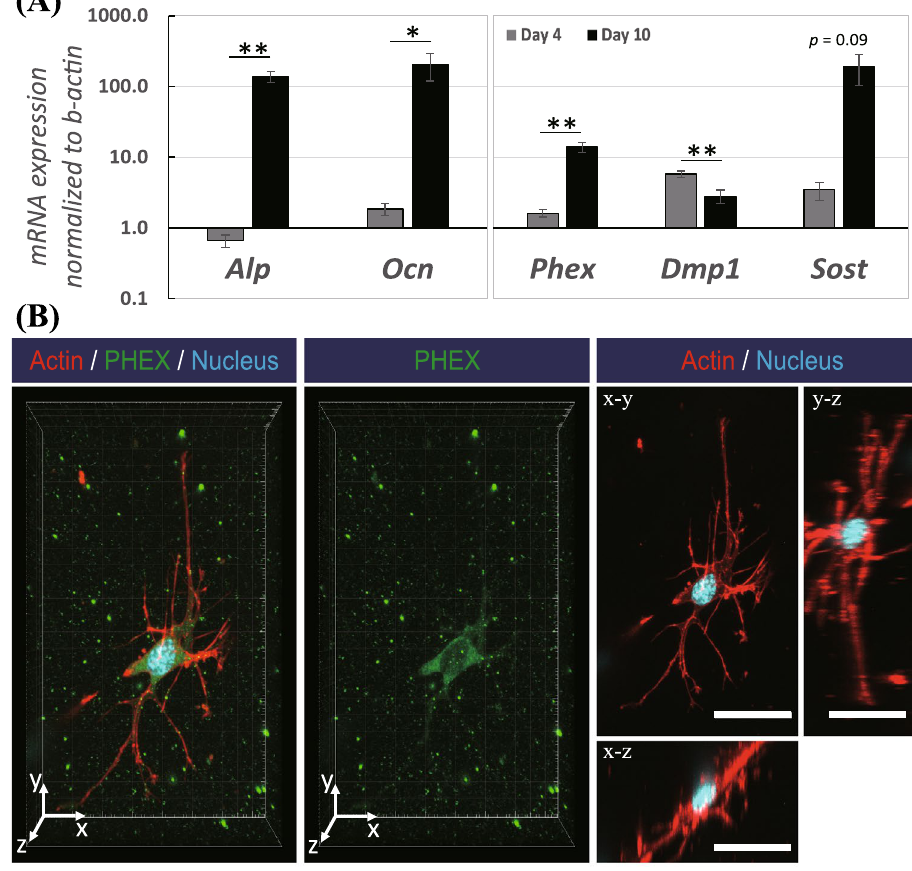
Figure 3. ( A ) The mRNA expressions of genes in osteoblast-like cells in the 2-side fixed matrix after 4 d and 10 d incubation. The mRNA expression of Alp , Ocn , Phex , Dmp1 , and Sost was measured by real-time PCR and normalized to that of β-actin . Bars represent the mean ± standard error ( n = 8; p -value was calculated by Student’s t -test; * p < 0.05, ** p < 0.005). ( B ) PHEX (green) immunostaining counterstained with actin rhodamine- phalloidin (red) and DAPI (cyan) of a cell migrated at 10–20 µm depth in the 2-side fixed matrix. Scale bars = 30